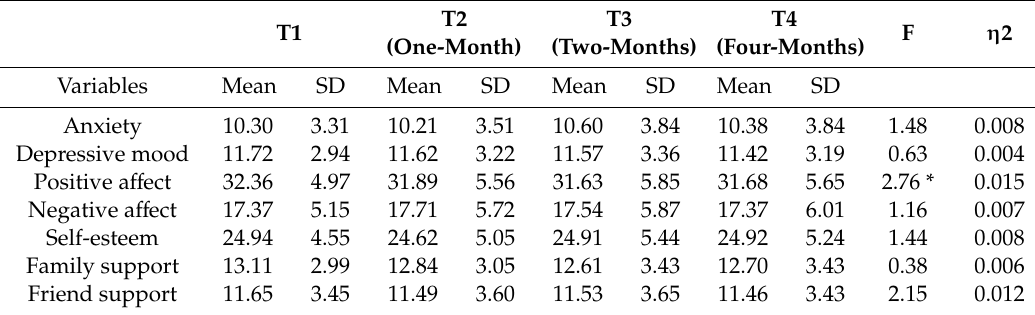
Table 3. Multivariate analysis of variance for depression, anxiety, a ff ectivity, self-esteem, and social support at the four time-periods ( N =